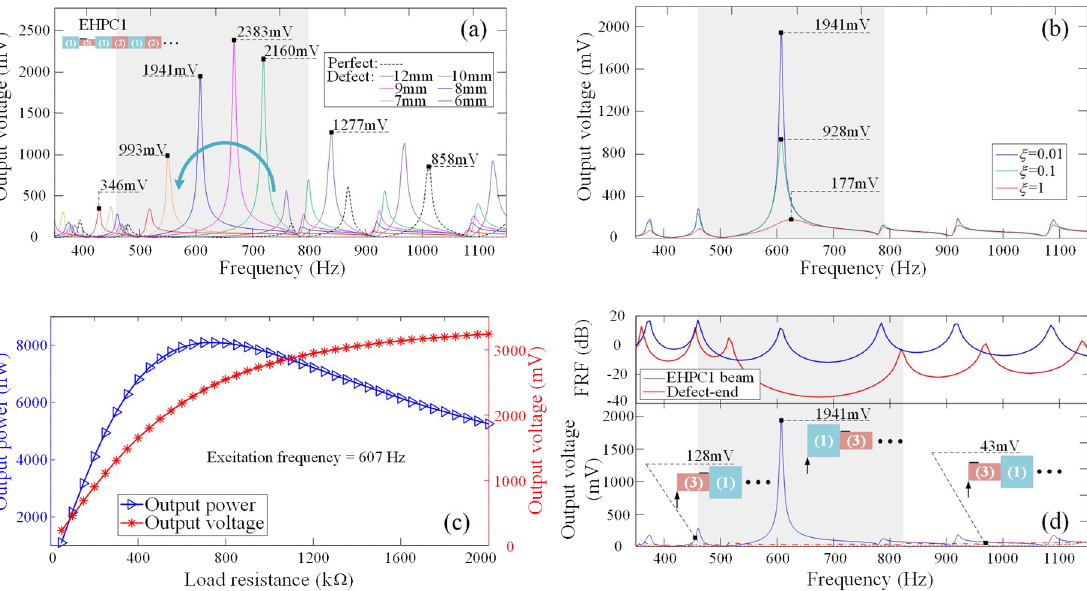
Figure 4. ( a ) Output voltage from the PC beams with different defect conditions. ( b ) Influences of the damping of the bonding layer. ( c ) Influences of the external load resistance to the output power and voltage. ( d ) Influences of the sequence of the defect segment in the first unit cell on displacement transmission and energy harvesting.